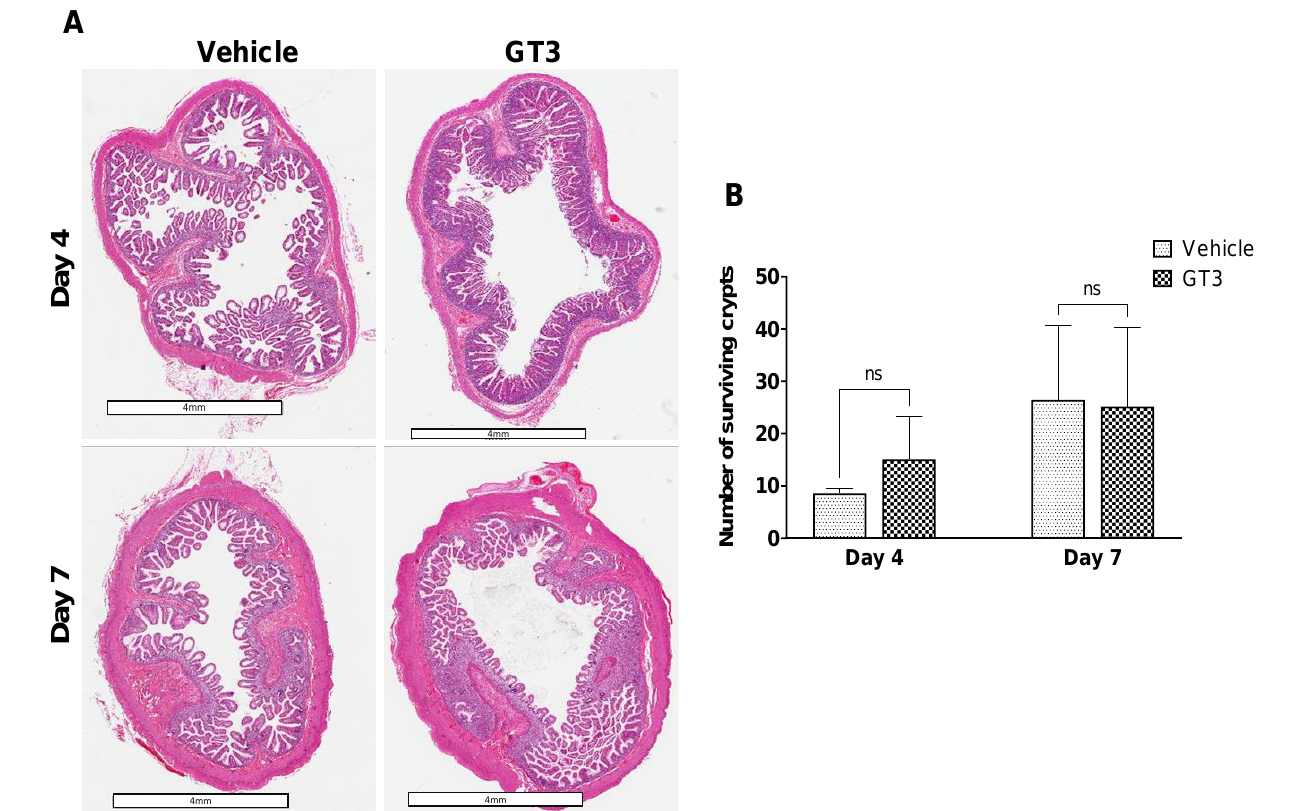
Figure 2. Effects of irradiation on crypt survival. ( A ) Representative images showing the transverse sections of proximal jejunum from NHP treated with vehicle or GT3 at day 4 and 7 post-irradiation. ( B ) Surviving crypts. The data are presented as average ± SEM; N = 3 (day 4) and N = 5 (day 7). ns = not significant.